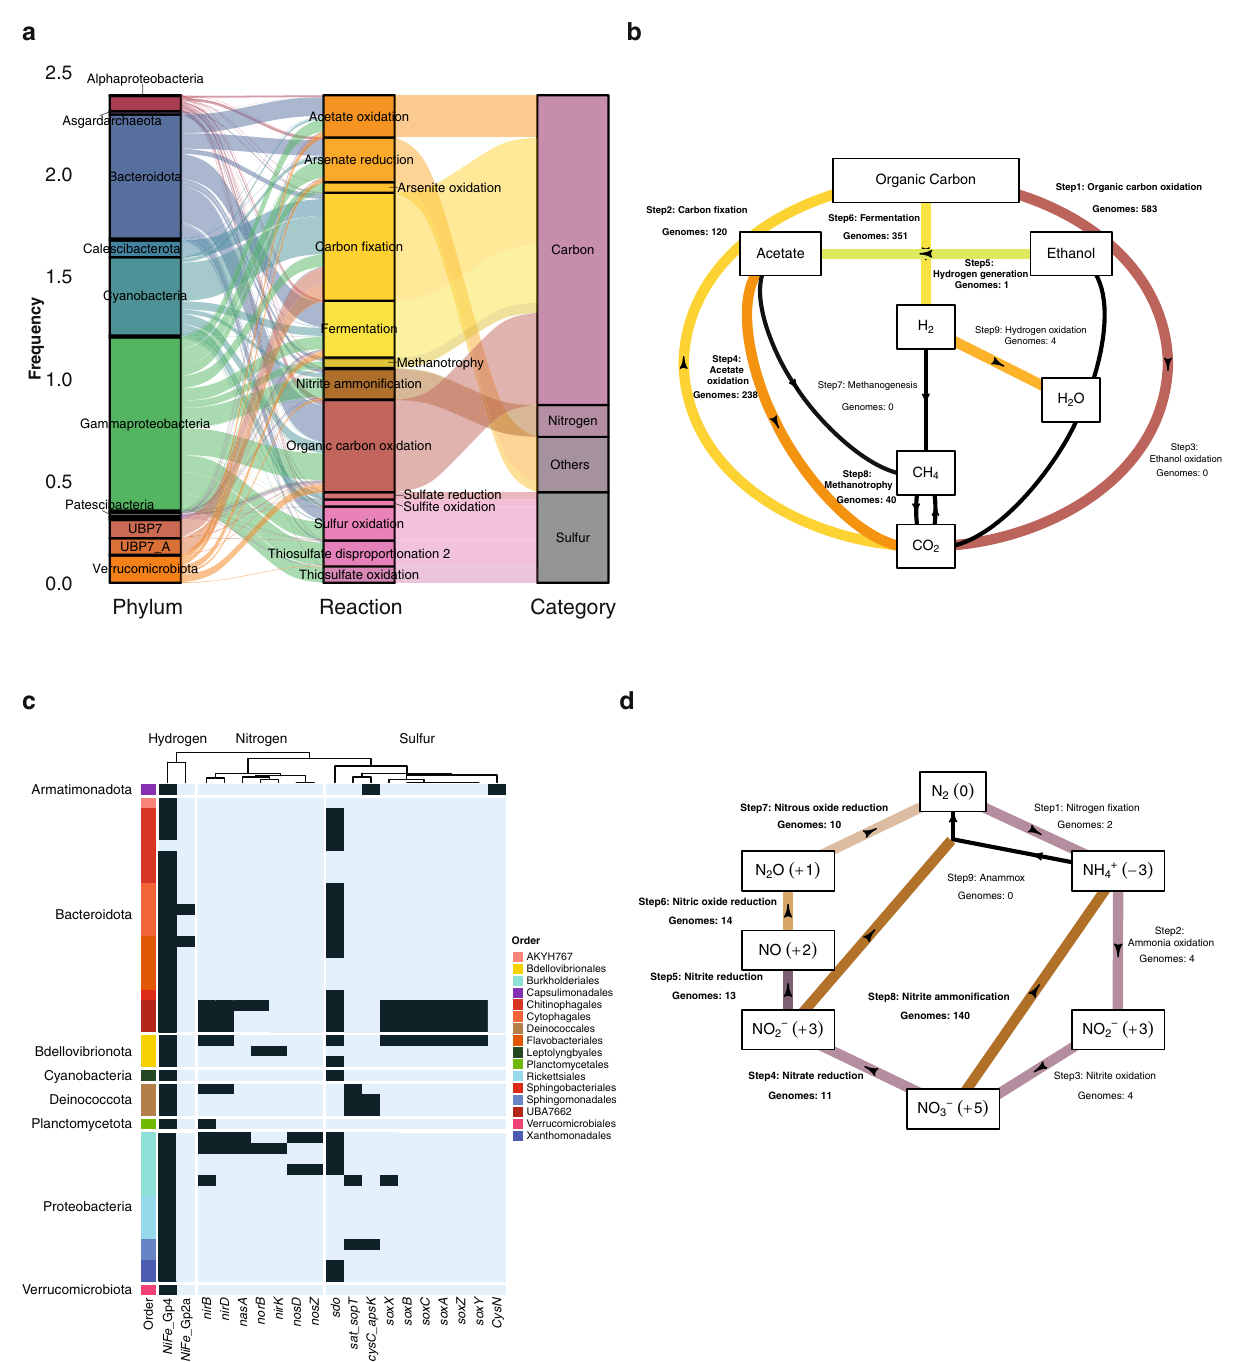
Fig. 4 Functional redundancies across MAGs enable diverse energy acquisition and biogeochemical pathways. a The alluvial plot represents the metabolic pathways identi fi ed within all prokaryotic MAGs, with the respective taxonomic classi fi cation and category of nutrients. b Total number of MAGs encoding genes for and involved in the Carbon cycle (Methods) are depicted in the fl ow gram created using a modi fi ed script from METABOLIC 109 . Each sub-pathway is indicated as a step with the corresponding number of genomes encoding the respective genes. c Phylum and order-level distributions of chemolithotrophic (hydrogen, nitrogen and sulfur) pathways with the respective gene copies per pathway are depicted in the heatmap. d Flow diagram indicating the MAGs encoding for pathways in the nitrogen cycle (Methods). Each sub-pathway is indicated as a step with the corresponding number of genomes encoding the respective